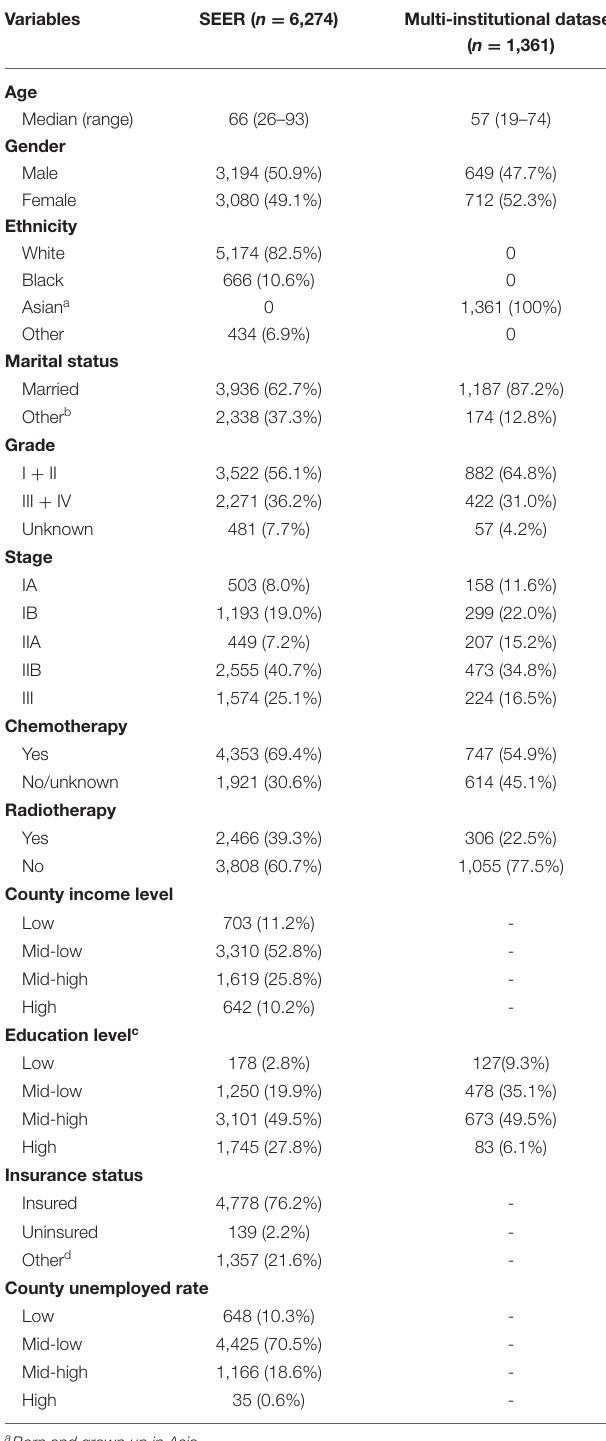
TABLE 1 | Baseline clinicopathologic characteristics of PDAC